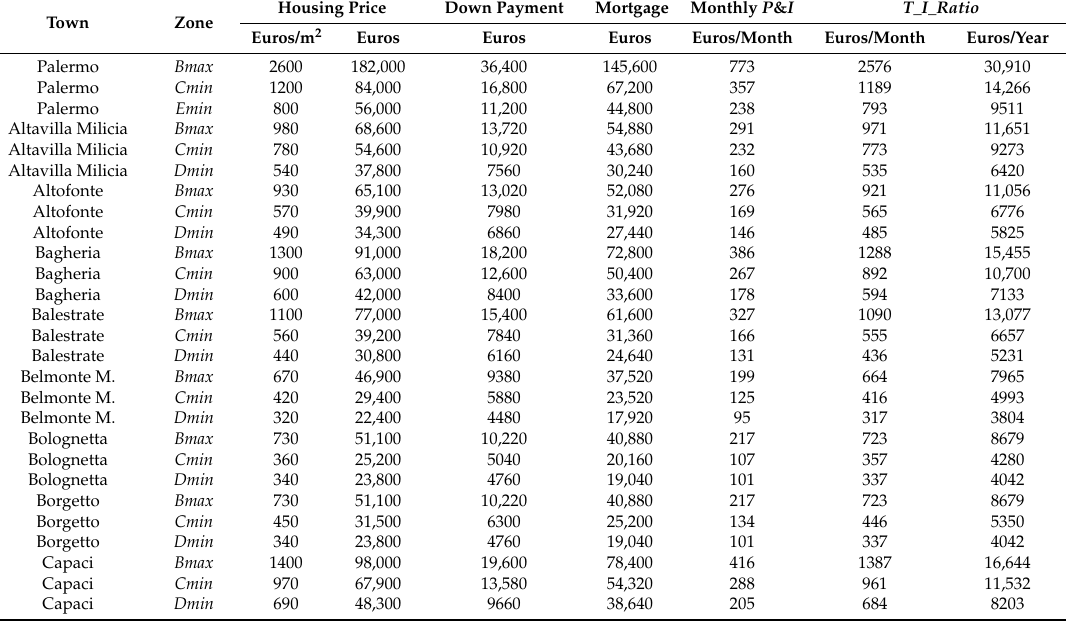
Table 3. Calculation of the T_I_ratio in some towns of the NWS area (other data omitted).